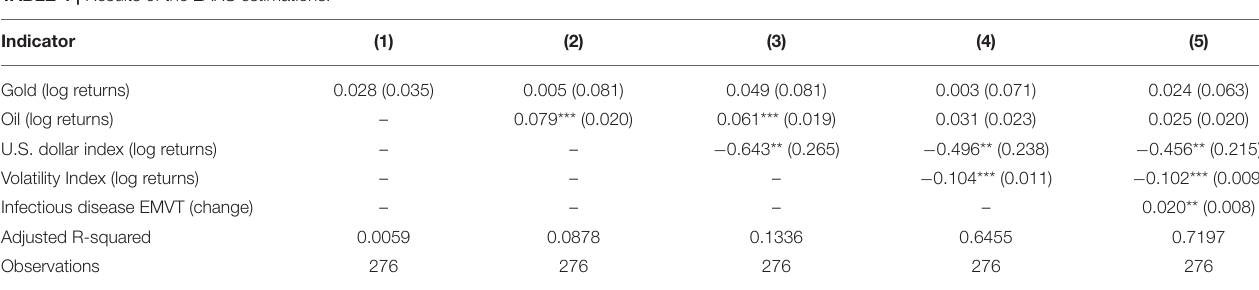
TABLE 4 | Results of the LARS